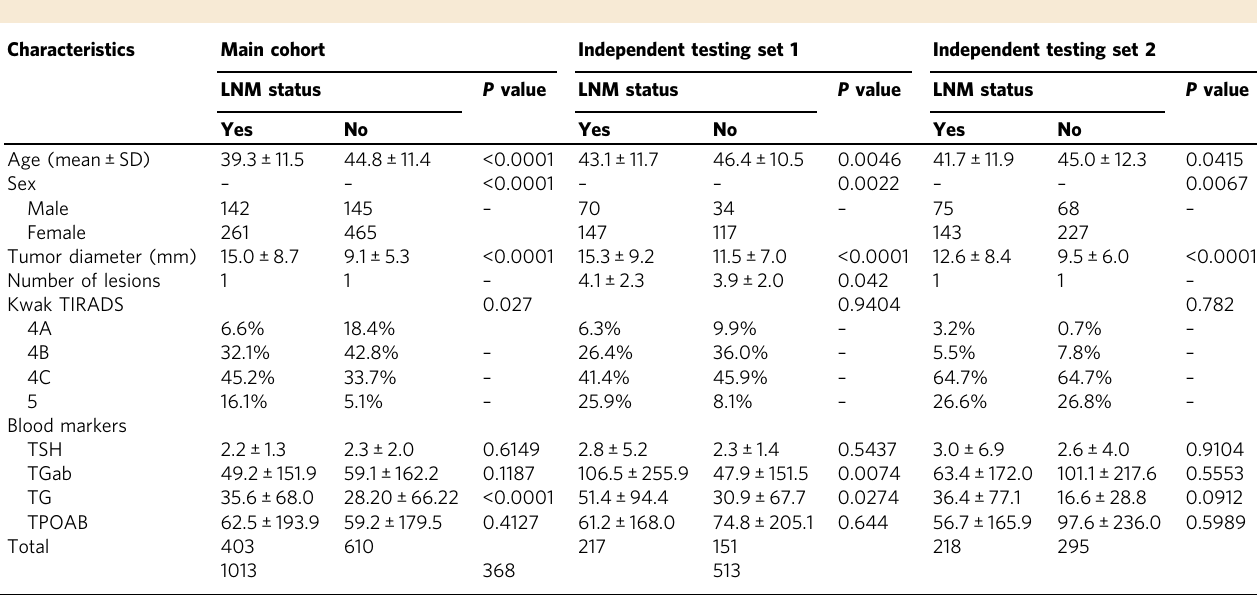
Table 3 Patient characteristics of three